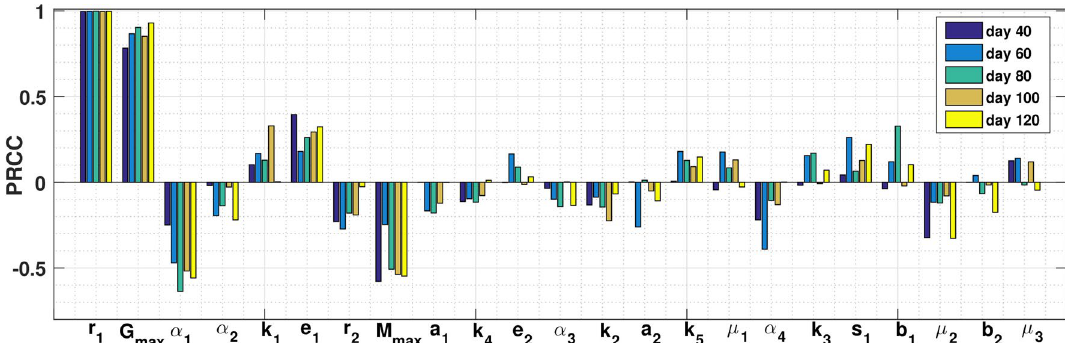
Figure 2. PRCC results indicating sensitivity indices for the system parameters in absence of diffusion with glioma cell population chosen as a baseline PRCC variable at five different time points with p < 0.0001